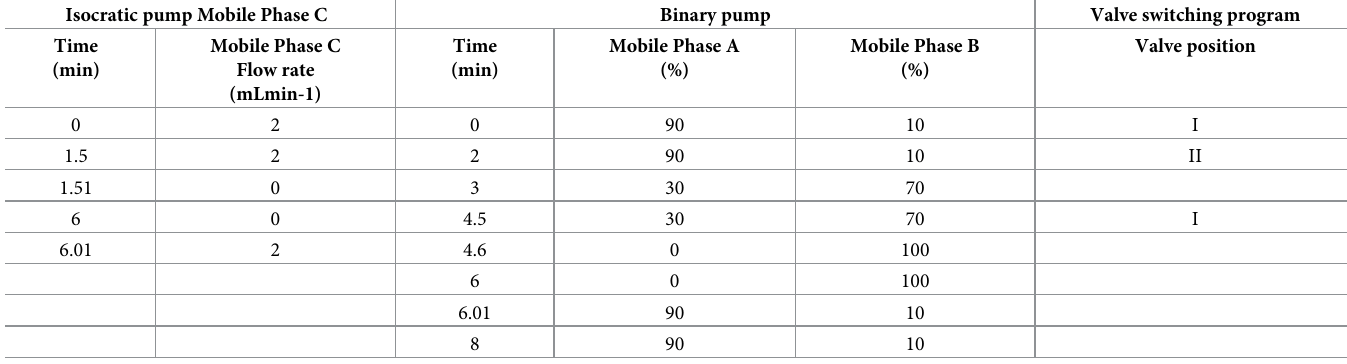
Table 1. The online SPE-HPLC-MS/MS gradient elution and valve switching program. Isocratic pump Mobile Phase C Binary pump Valve switching